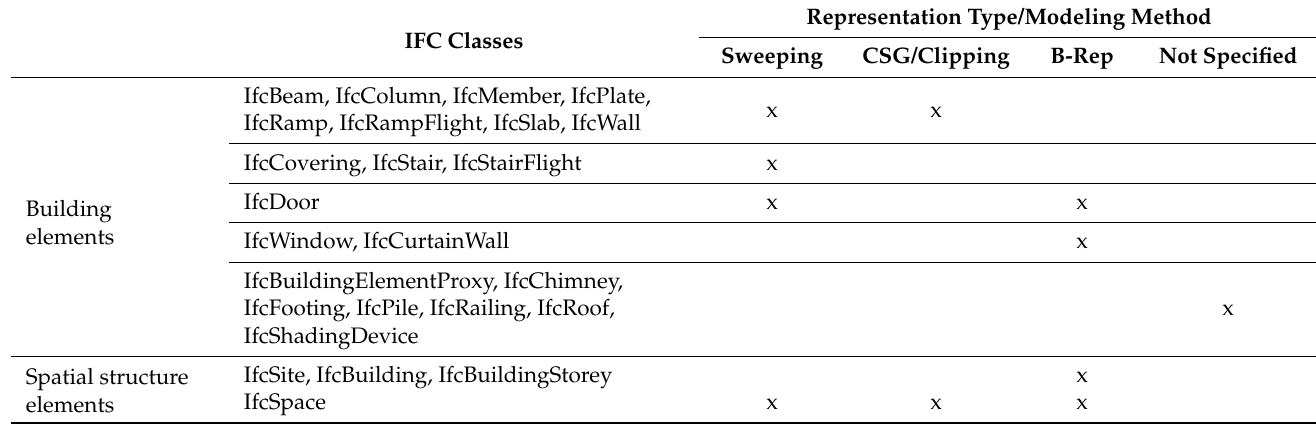
Table 1. Building elements, spatial elements, and supported